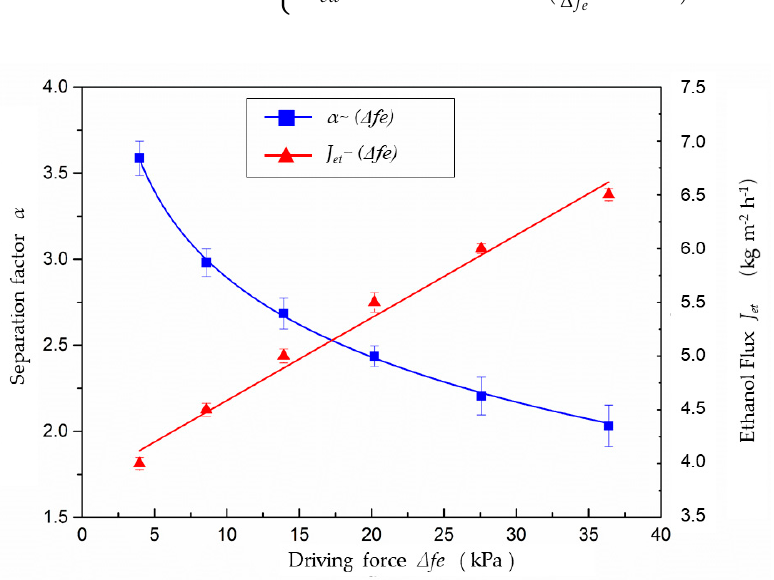
Figure 4. Experimental ethanol flux and separation factors at different driving force.